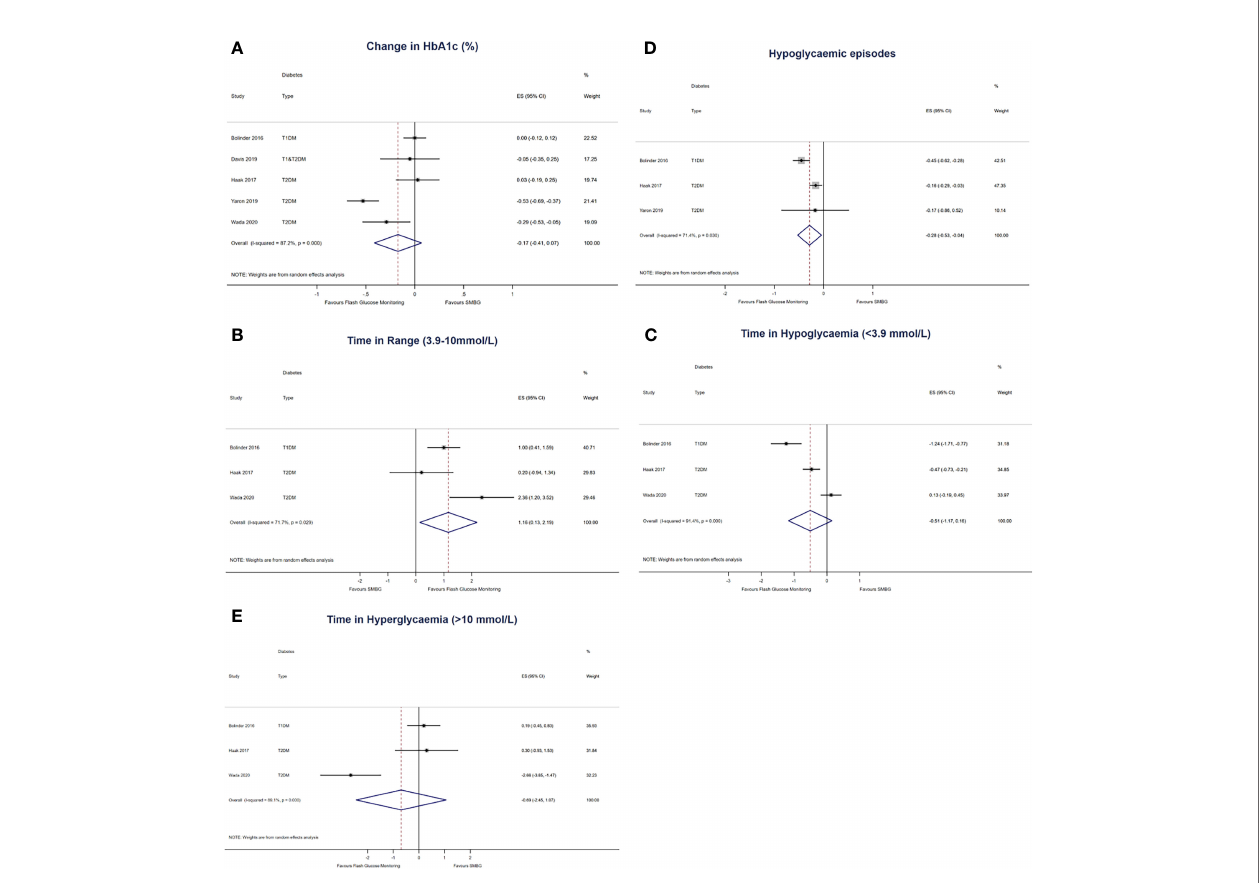
FIGURE 2 | Forest plots of the effect size of (A) fi rst-row left: change in HbA1c from baseline to last follow-up, expressed in % in all 5 comparisons. (B) fi rst-row right: change in time in range (3.9 – 10mmol/L) per 24 hours, expressed in hours (C) second-row left: change in time in hypoglycaemia (<3.9mmol/L) per 24 hours, expressed in hours (D) second-row right: change in number of hypoglycaemic episodes per 24 hours (E) third-row left: change in hyperglycaemia (>10mmol/L), expressed in hours. The results are expressed as mean differences, compared to participants that used